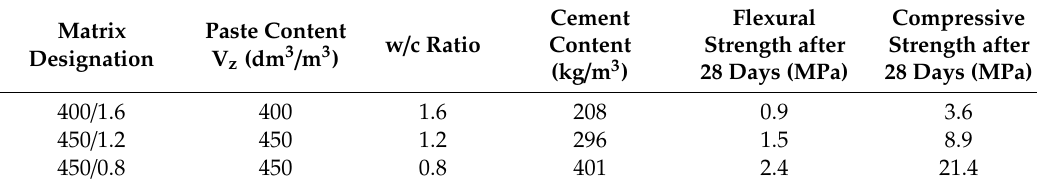
Table 4. Basic properties of three soil-cement matrices selected for